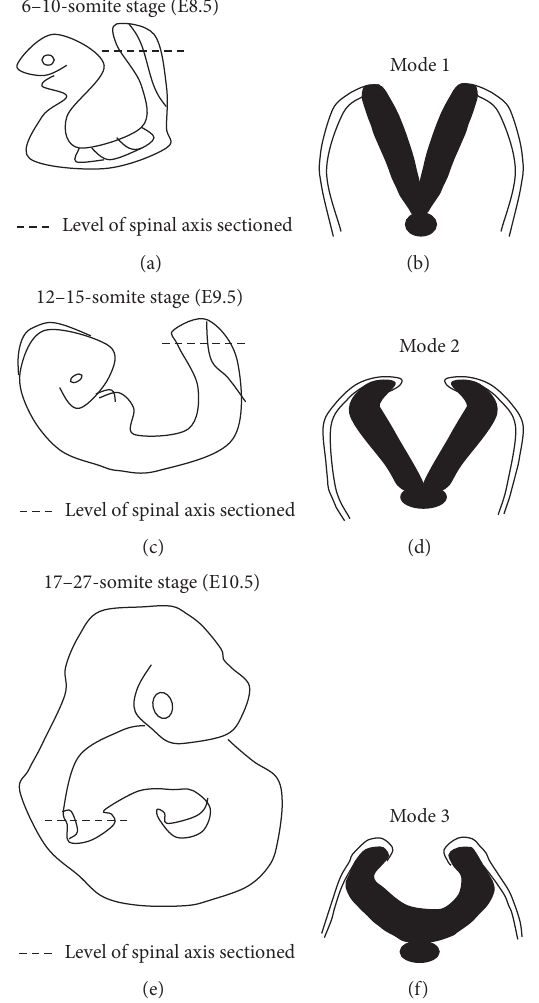
Figure 4: Schematic figure showing progressive developmental stages of the mouse embryo and sections through the PNP at these stages. (a) Schematic of embryo at 6–10-somite stage, which has already undergone closure (1); (b) section through PNP of (a), depicting Mode 1 neurulation; (c) schematic of embryo at 12–15-somite stage; (d) section through PNP of (c) exhibiting Mode 2 neurulation; (e) schematic of embryo which has undergone closures (1), (2), and (3) with PNP being the only remaining unfused section of the neural tube; (f) section through PNP of (e) depicting Mode 3